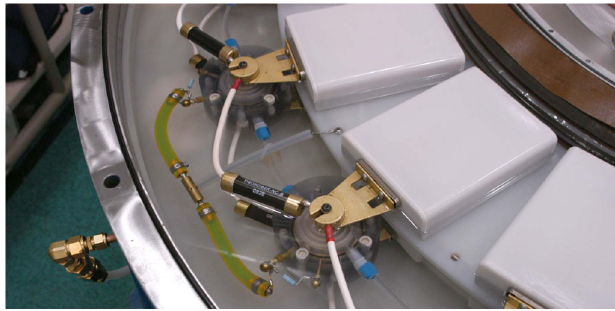
FIG. 6. Details of LTD-III connections with 40-nF capacitors, solid-state charge resistors, and liquid trigger